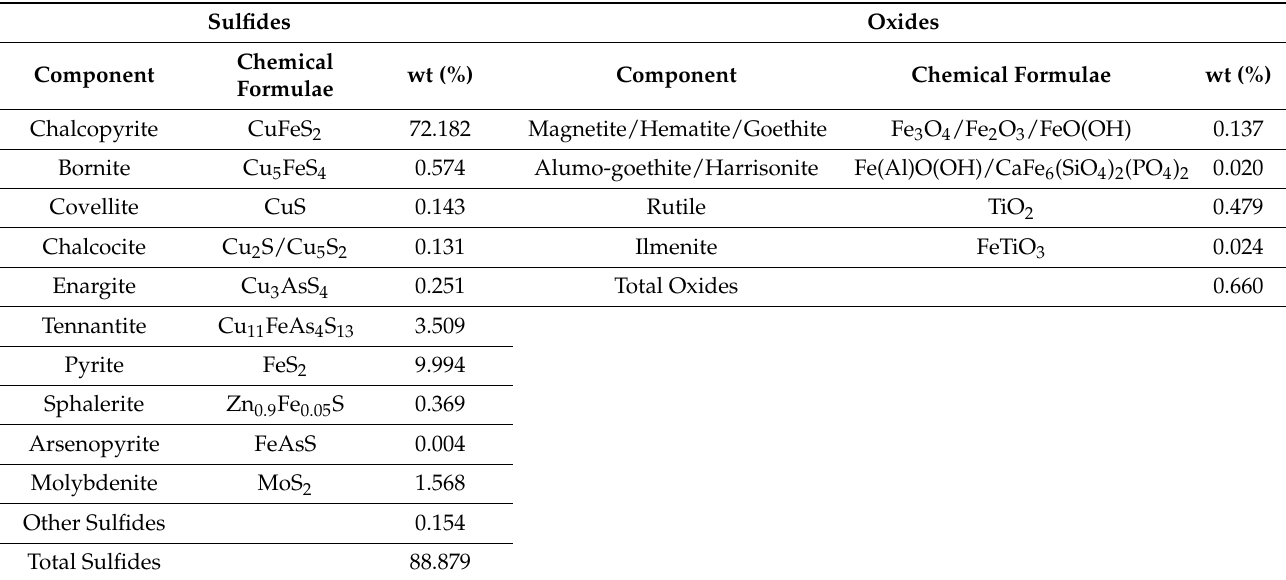
Table 1. Weight percentages of metal sulfides and oxides of the mineral concentrate.